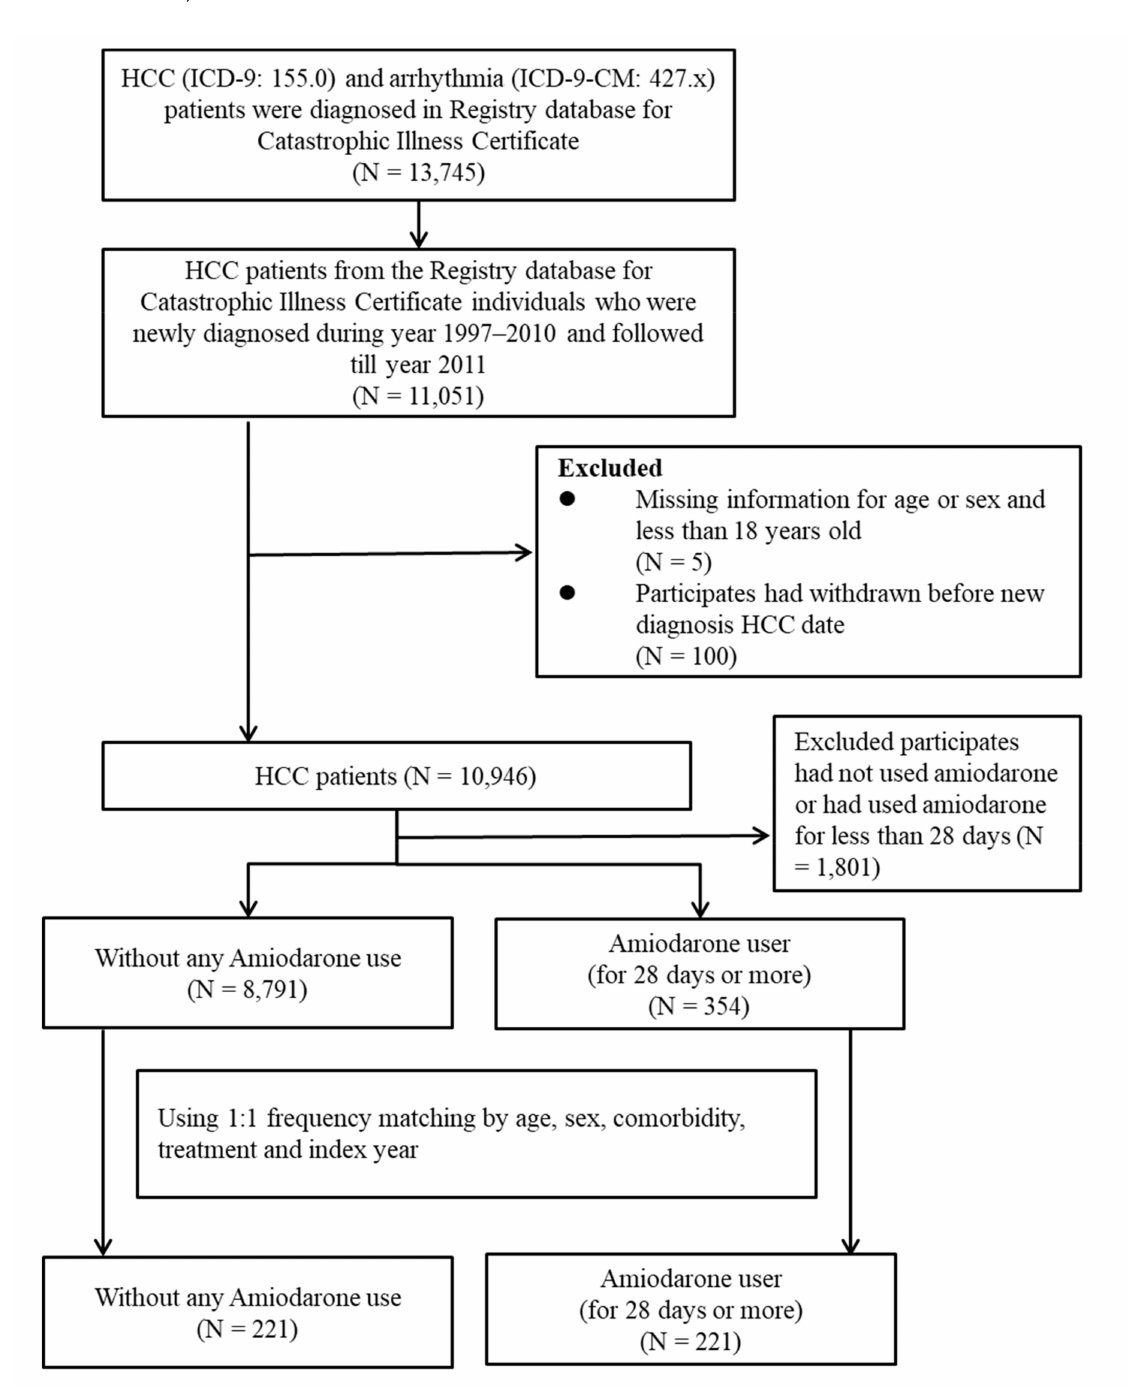
Figure 1. Flow chart of study cases (hepatocellular carcinoma, HCC) from the Longitudinal Health Insurance Database (LHID2000) in Taiwan during